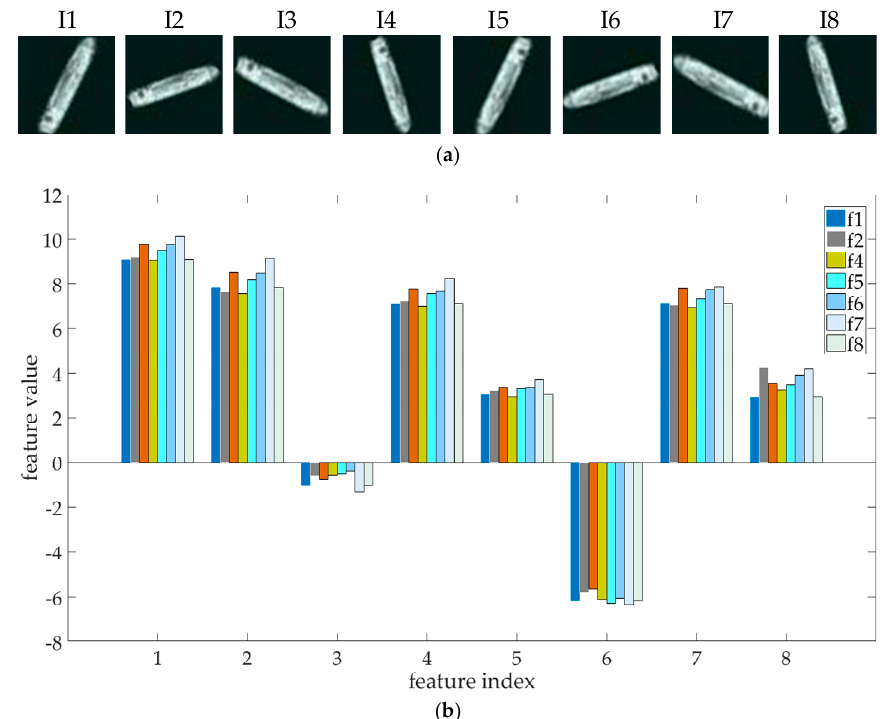
Figure 9. The demonstration of rotation-invariant features of the ship targets. ( a ) A series of patches with different angles denoted as Ik (k = 1,..,8). ( b ) Their corresponding output feature vectors fk. Note that only the first eight feature dimensions are shown in the bar chart.